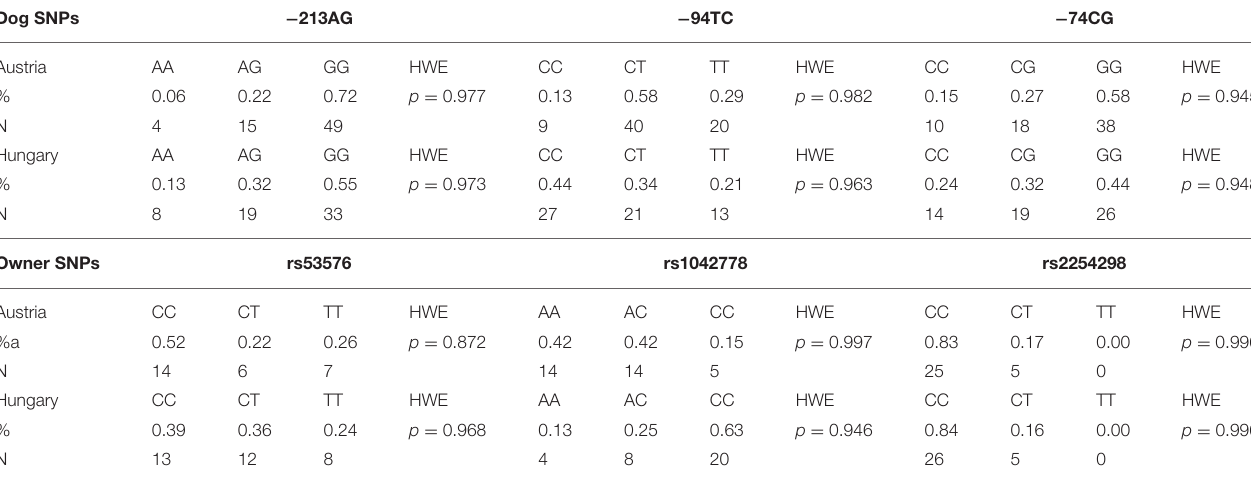
TABLE 1 | Allele frequencies (%) and number of individuals (N) for Border collies and Owners from Austria and Hungary. Dog